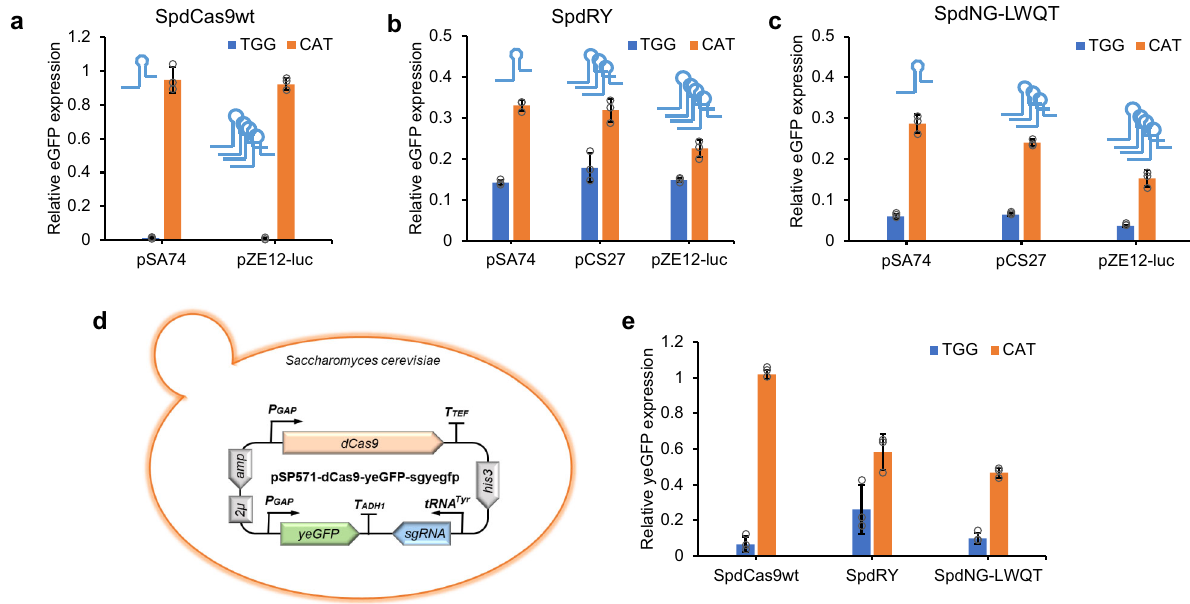
Fig. 5 Transcriptional repression of eGFP in E. coli and S. cerevisiae . Repression of chromosomal eGFP by SpdCas9wt ( a ), SpdRY ( b ) and SpdNG-LWQT ( c ) targeting both 5 ′ -TGG-3 ′ (blue) and 5 ′ -CAT-3 ′ (orange) PAMs in E. coli BW25113(F ′ )::eGFP. The dCas9s were expressed on pCS27, and sgRNAs were expressed on low-copy (pSA74), medium-copy (pCS27), or high-copy (pZE12-luc) plasmids. d Construction of pSP571-dCas9-yeGFP-sgyegfp plasmid for gene repression assay in S. cerevisiae . The dCas9s and the yeast eGFP (yeGFP) were driven by the P GAP promoter, and sgRNAs were driven by the tRNA Tyr promoter. e Comparison of yeGFP repression by SpdCas9wt, SpdRY and SpNG-LWQT targeting both 5 ′ -TGG-3 ′ (blue) and 5 ′ -CAT-3 ′ (orange) PAMs in S. cerevisiae . Data indicated the mean ± standard deviation ( n = 3 independent biological replicates). Source data are provided as a Source Data fi